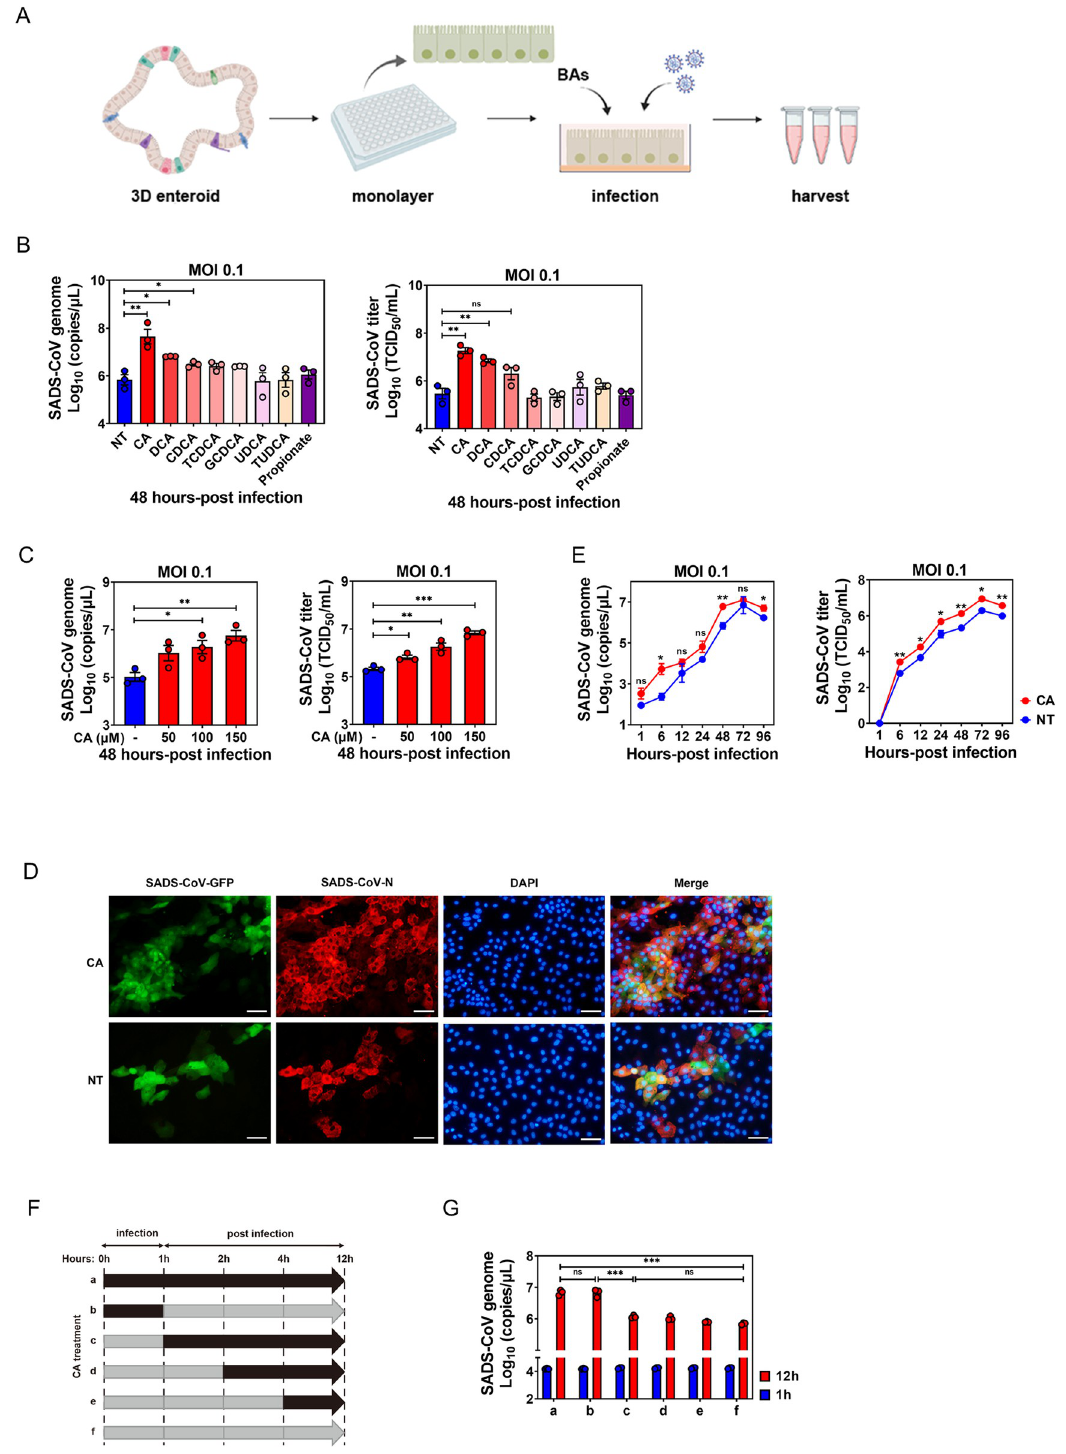
Fig 3. Bile acids (BAs) promote SADS-CoV replication and affect the early stage of viral infection in PIEs. (A) Schematic illustration of BA treatment in SADS-CoV-GFP infection. The image was created using the website https://app.biorender.com/. (B) Ileal PIE monolayers were inoculated with SADS-CoV-GFP at MOI = 0.1 alone or simultaneously with BAs for 48 h at 37˚C. All BAs were added to a final concentration of 100 μ M, and propionate control to 1 mM. Viral genomic copies and titer were quantified by RT-qPCR and TCID 50 . (C) PIE monolayers infected with SADS-CoV-GFP for 48 h in the presence of different